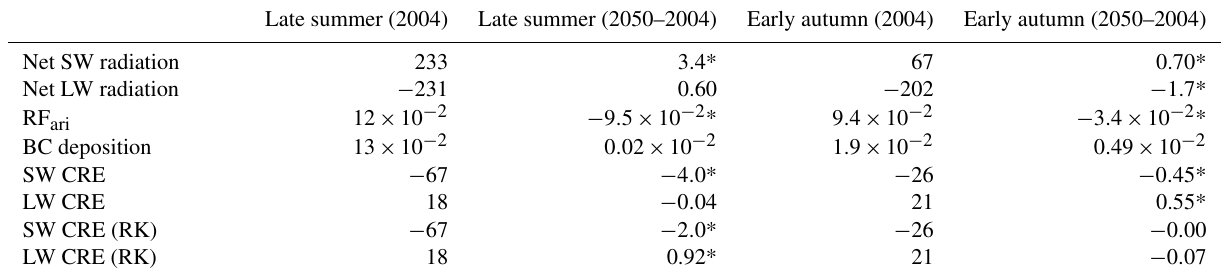
Figure 8. SW and LW CRE in 2004 in (a) and (d) and differences between 2050 and 2004 (i.e. between simulations arctic_2050_EM2004 and arctic_2004) in (b) , (c) , (e) , and (f) in early autumn (September–October). In (b) and (e) , the changes in CREs were calculated online from two radiation calls (once with, once without clouds). In (c) and (f) , the changes in CREs were calculated with the radiative kernel (RK) method (see text for more details). Hatched areas are significant at the 95% confidence level. Table 4. Absolute values for the year 2004 and differences between 2050 and 2004 (i.e. arctic_2050_EM2004–arctic_2004) in radiation, radiative forcings, and CREs (in Wm − 2 ) averaged over all latitudes north of 60 ◦ N in late summer (July–August) and early autumn (September–October). The arctic_2050_EM2004–arctic_2004 simulation accounts for changes between 2050 and 2004 associated with a warmer climate, which leads to a reduction in SIC and therefore increased natural aerosol emissions. RK stands for radiative kernel method (see text for details). The star (*) denotes changes that are significant at α =